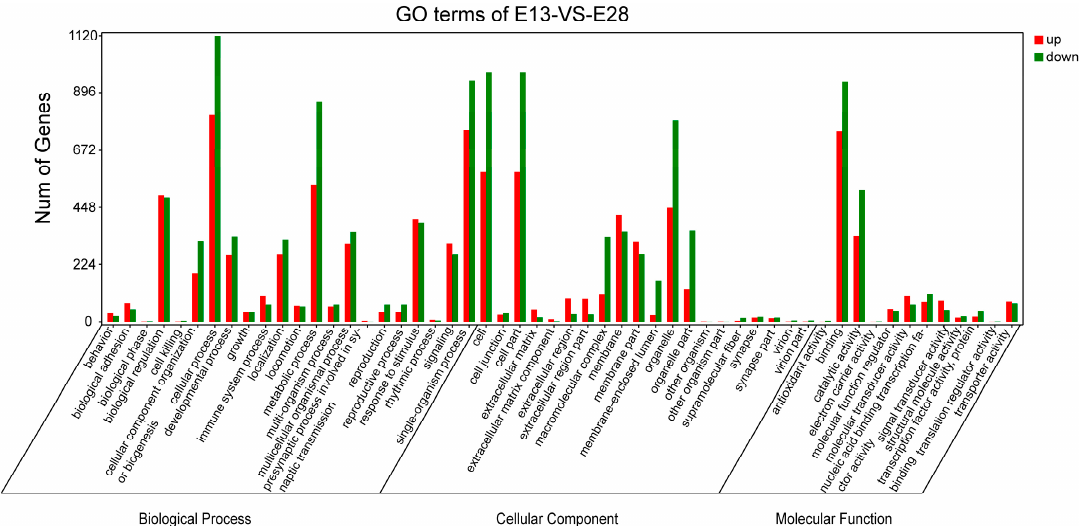
Figure 3. Gene Ontology (GO) classifications of DEGs among libraries in E13 vs. E28. The results are summarised in three main categories: biological process, cellular component, and molecular function. The X -axis indicates the secondary classification of hierarchical GO terms; The Y -axis shows the number of genes.